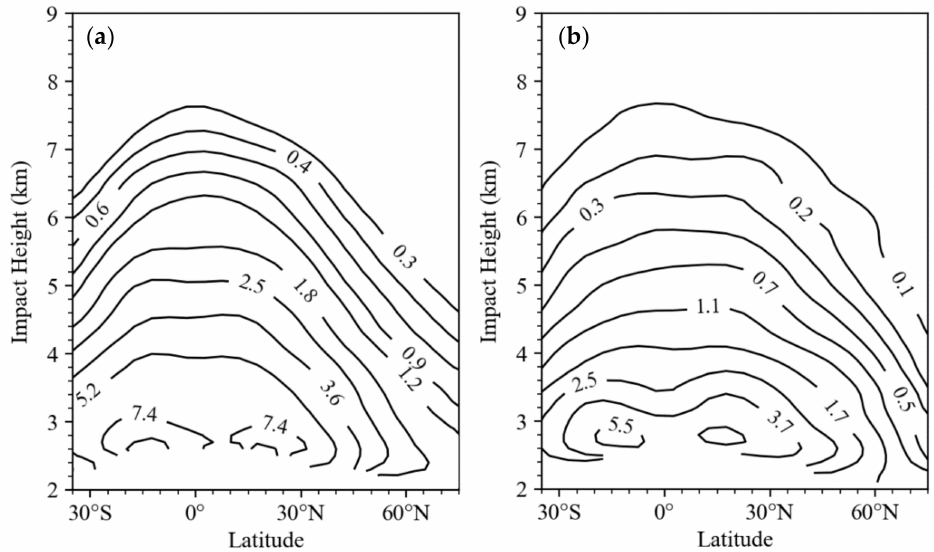
Figure 7. ( a ) The mean ( µ and ( b ) standard deviation ( σ ) of the RO bending angle error variance (unit: 10 − 6 rad 2 ), in which contours are plotted at the interval of log µ = 0.3 and log σ = 0.3 for ( a ) and ( b ),